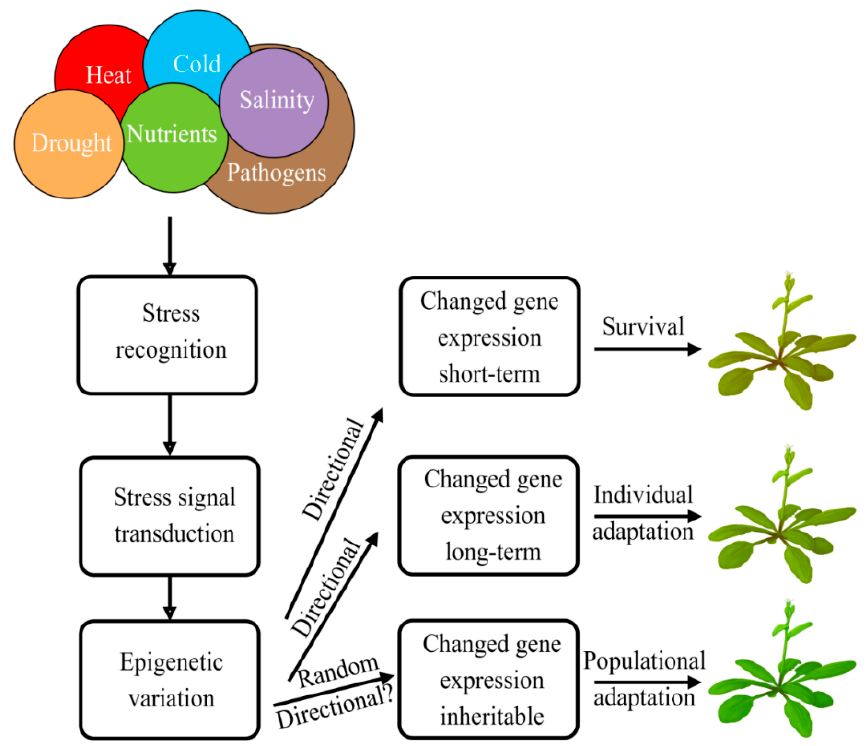
Figure 1. Epigenetic mechanisms of the short-term and long-term plant adaptation to environmental stresses.